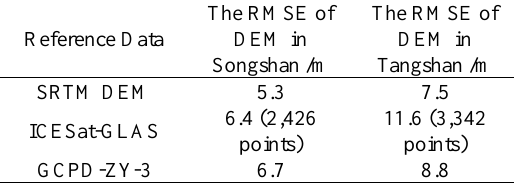
Table 7. The accuracy of DEM elevation invalid points. Further, we keep the points of the GLAS and SRTM DEM elevation difference for less than 32m. Then we calculate the RMSE of GLAS points according to 90% point-to-point precision. At last, the RMSE is 6.4 m and 11.6m in Songshan and Tangshan region, by 2,426 points and 3,342 points evaluations,